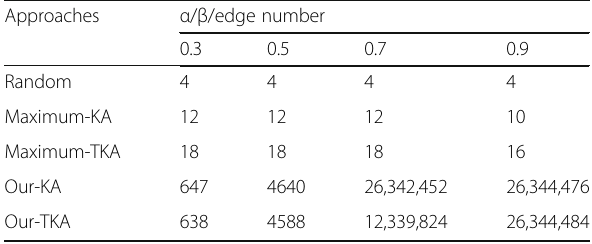
Table 2 The different parameters are employed in the weighted similarity function WCN, and λ = 0.9 to obtain the